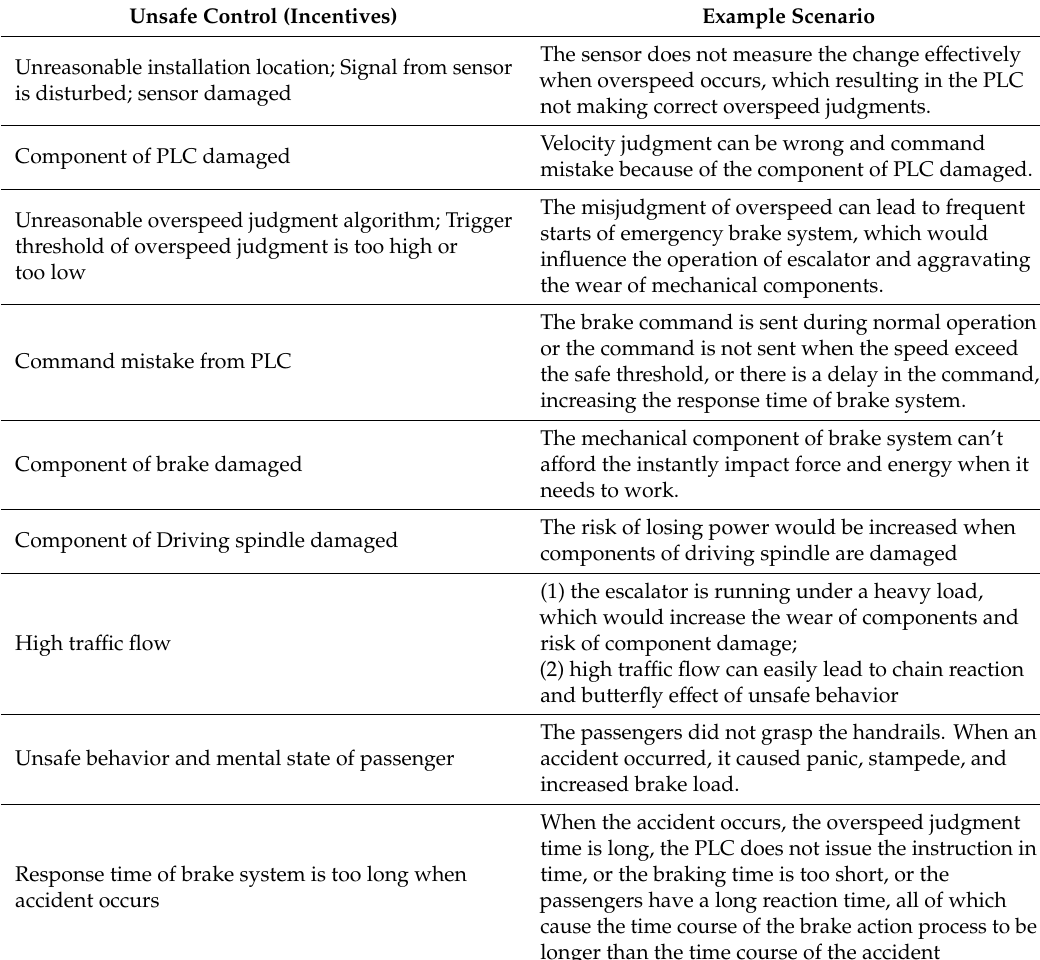
Table 7. Specific example Scenarios of hazardous unsafe